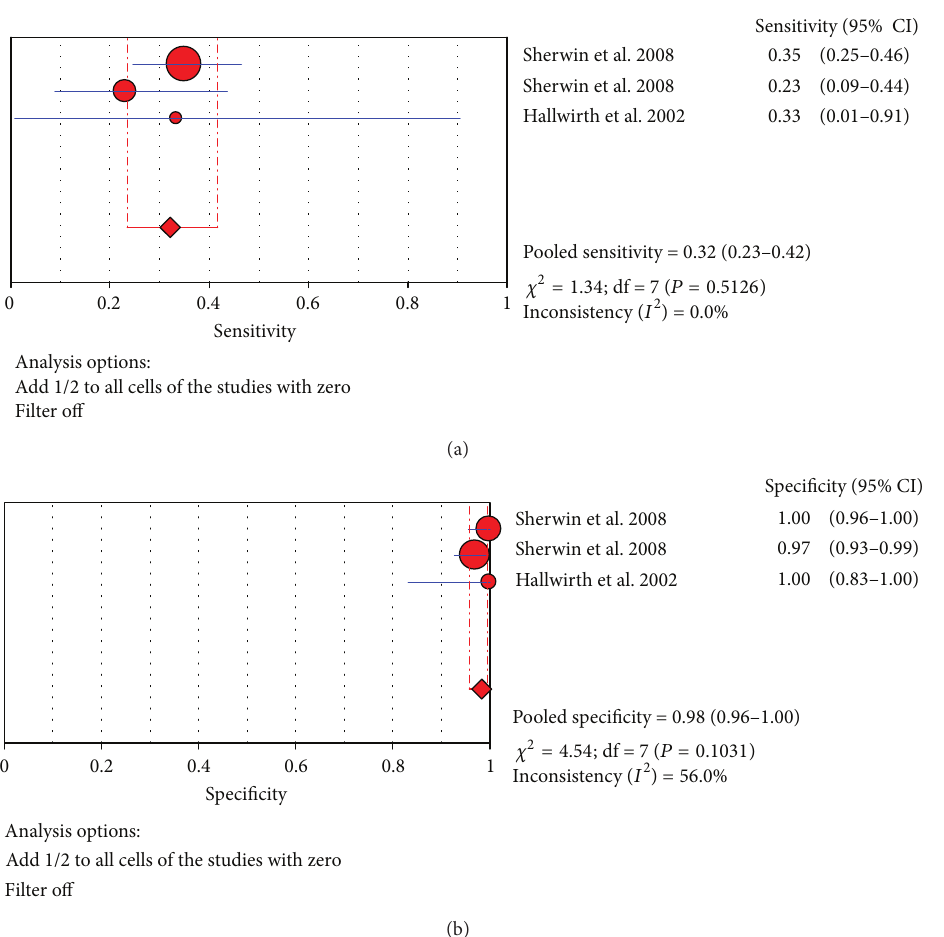
Figure 11: Forest plot for sensitivity and specificity of the TNF- 𝛼 test to diagnose neonatal sepsis at the LONS in the southern hemisphere.